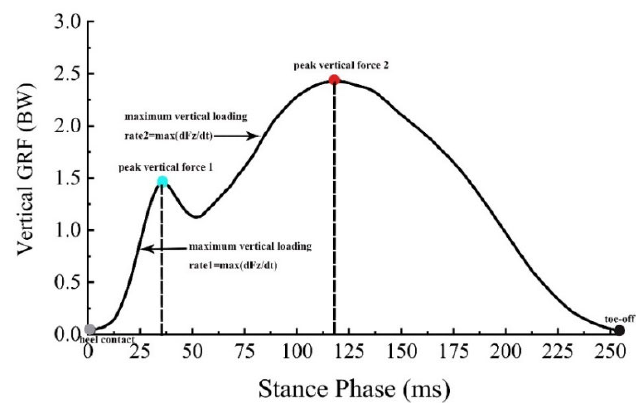
Figure 3. The time profile of vertical ground reaction force (GRF) during the stance phase for one representative trial. The peak vertical force 1 and 2 were shown in blue and red dots, respectively.